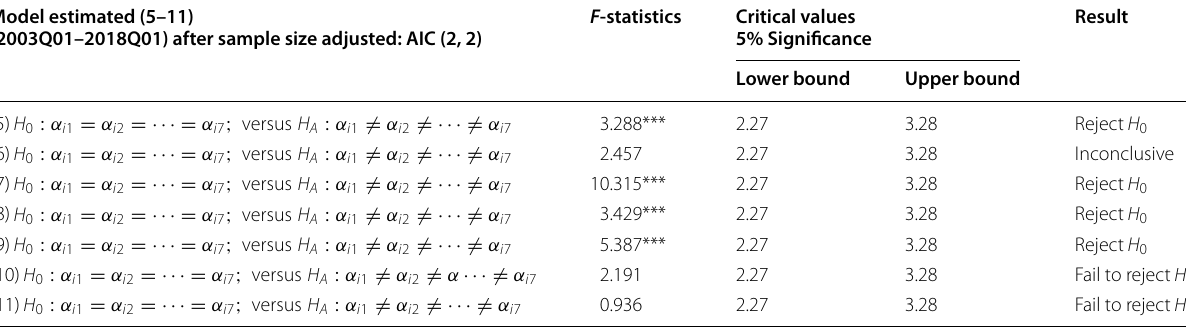
Significant if * F -statistics > upper bound critical values Inconclusive if F -statistics is between lower bound and upper bound critical values Critical values are obtained from Pesaran et al. [53] ***Significant at 1% level of confidence ( p < 0.01), **Significant at 5% level of confidence ( p < 0.05), *Significant at 10% level of confidence ( p < 0.10)